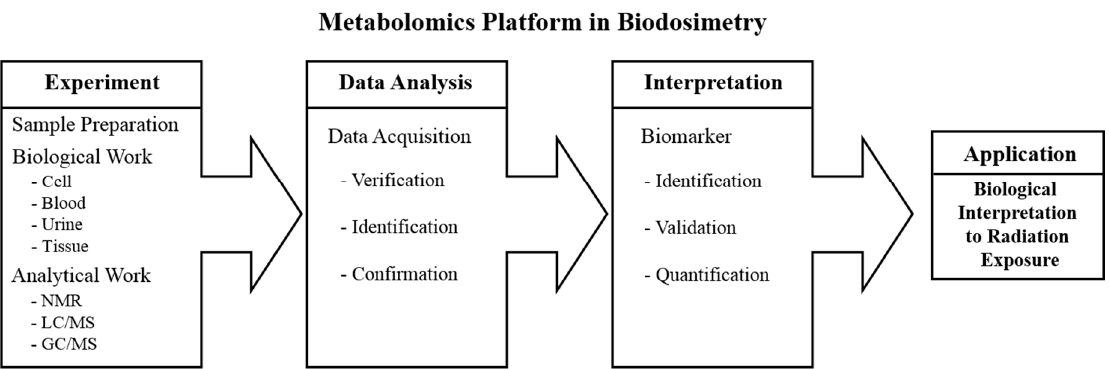
Figure 1. Workflow diagram involves the metabolomics approaches. Abbreviations: NMR, nuclear magnetic resonance; LC/MS, liquid chromatography/mass spectrometry; GC/MS, gas chromatography/mass spectrometry.